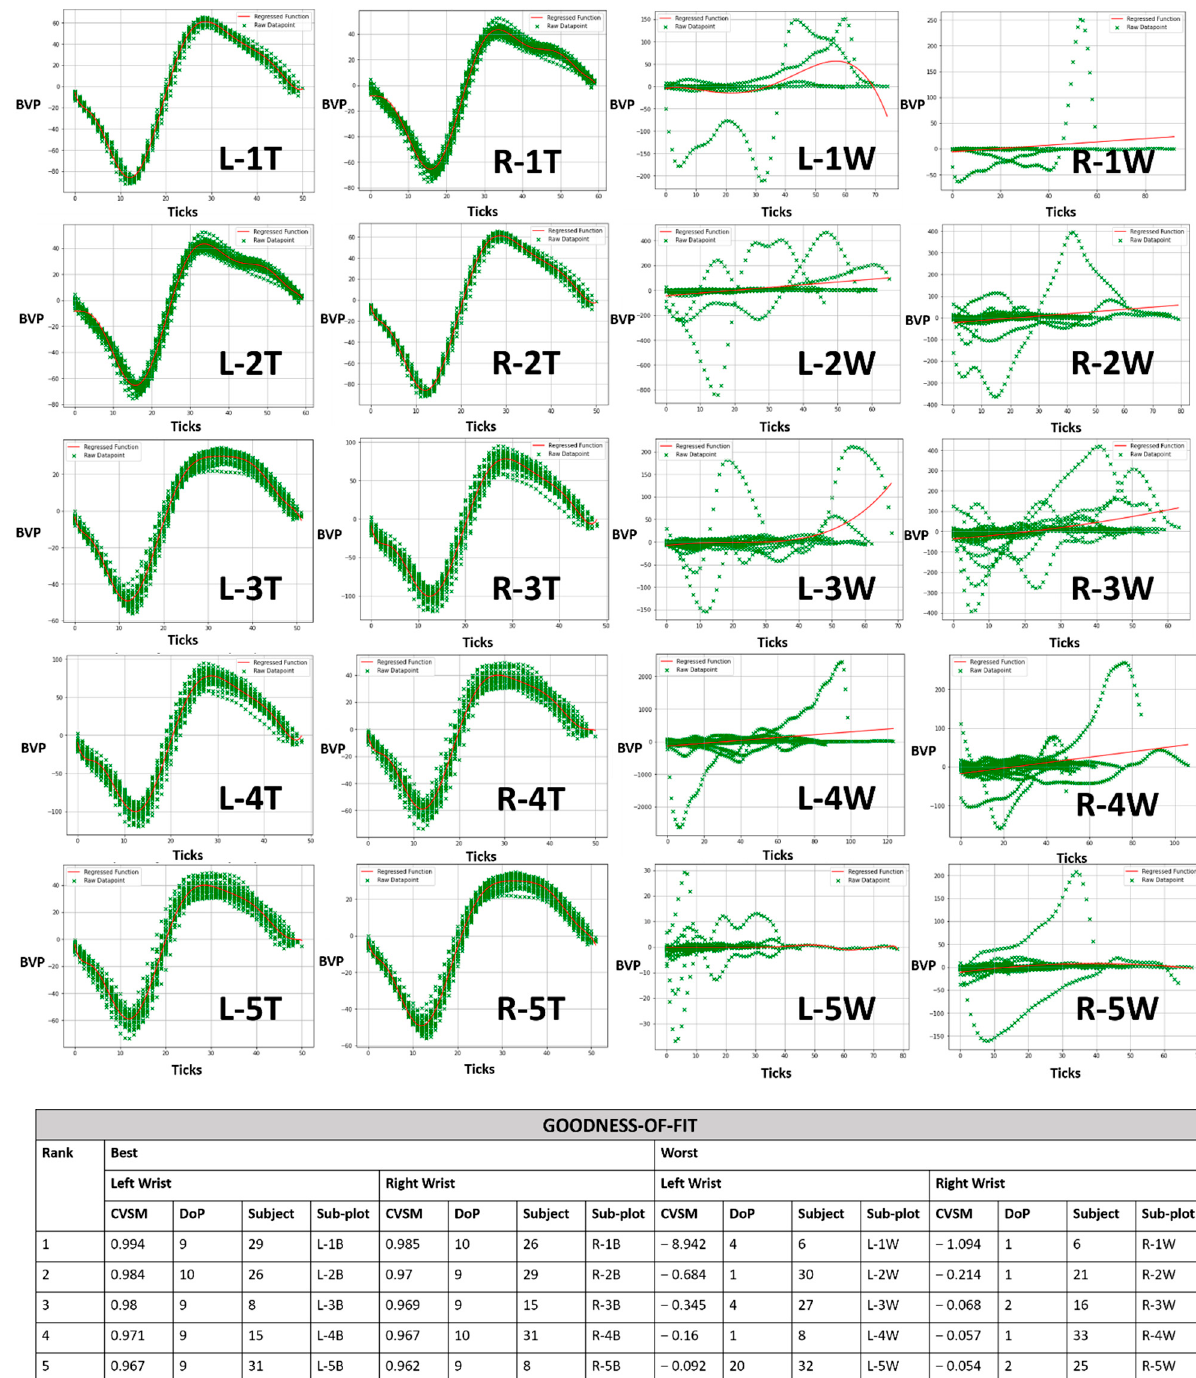
Figure 4. Goodness-of-fit of in-journey (IJ) datasets ranked by top five and worst five CVSMs. Each sub-plot consists of an Empatica E4 wristband’s blood volume pressure sensor value (BVP) versus ticks (sensor time interval). [Left wrist = L and right wrist = R].